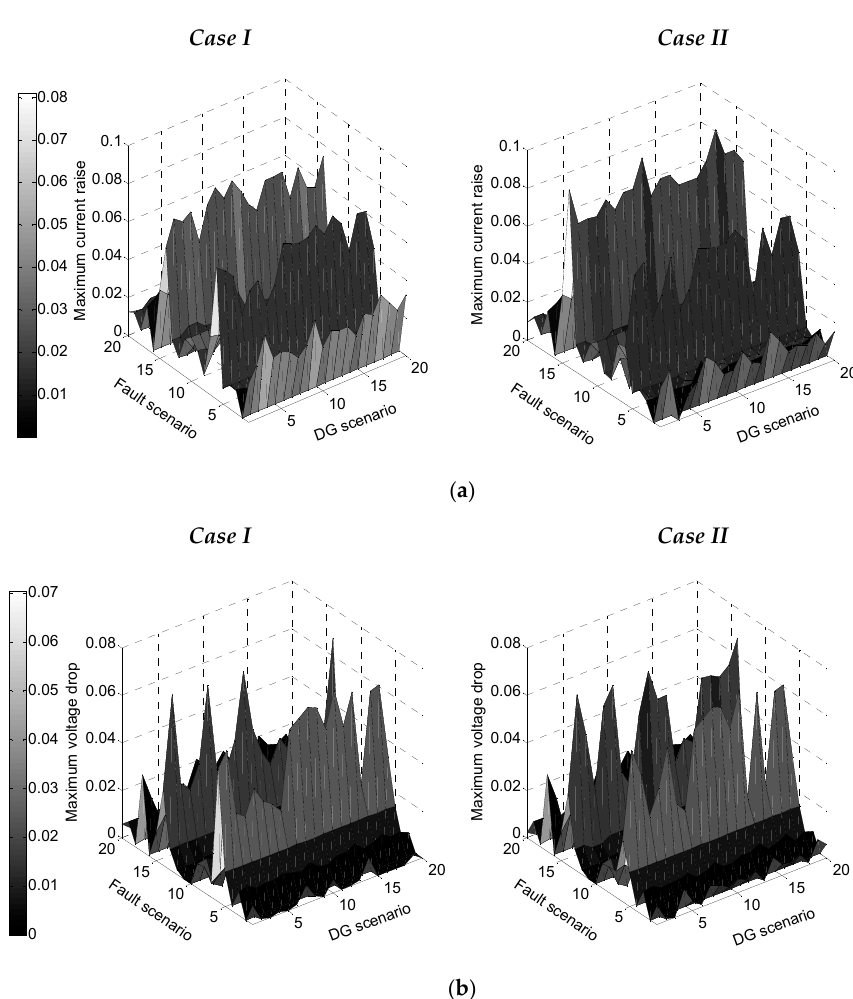
Figure 8. Performance of load restoration for case I and case II (our solution) ( a ) switcher operation times; and ( b ) power loss.